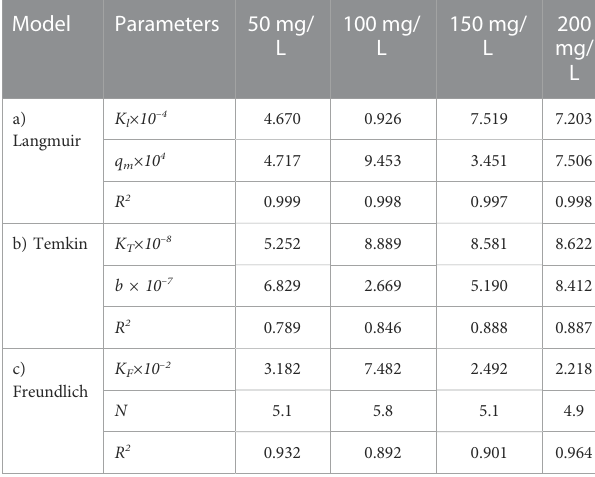
TABLE 13 Parameters of a) Langmuir, b) Temkin, and c) Freundlich isotherm models at different adsorbent amount using Oil sludge 2 as carbon active at T = 318 K and pH = 5.